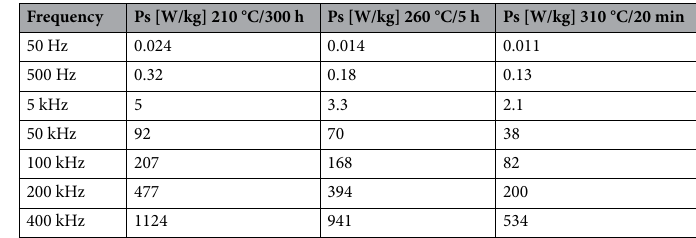
Table 1. Comparison of core power losses measured at B = 0.1 T in the frequency range from 50 Hz to 400 kHz.